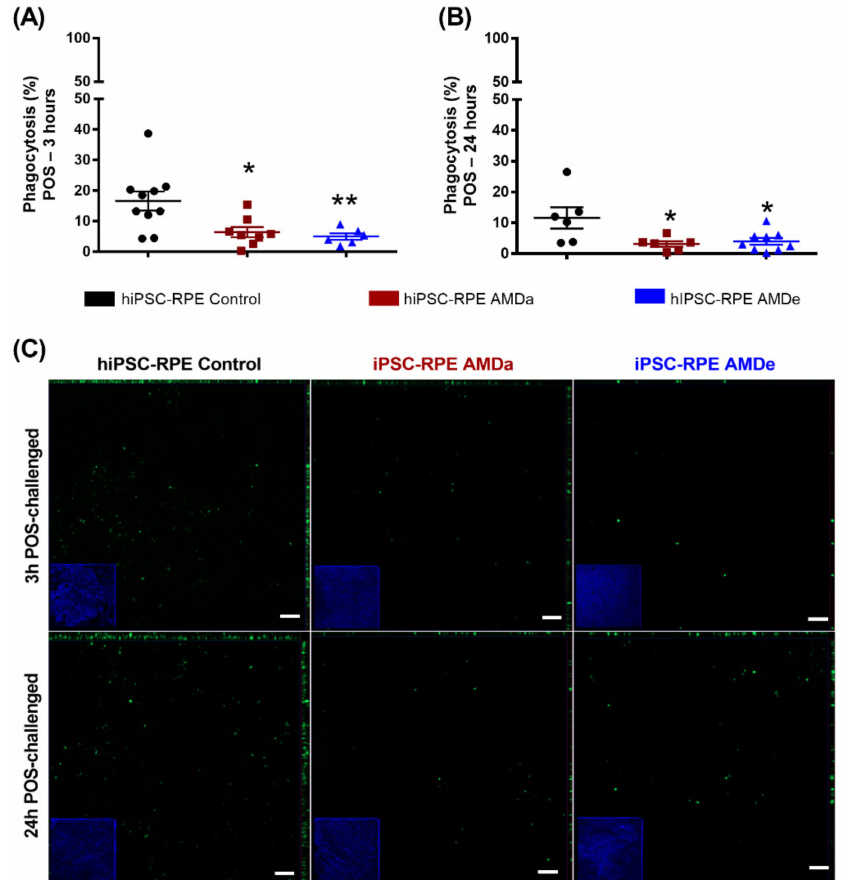
Figure 2. Specific phagocytosis function of hiPSC RPE Control and AMDa/e cell lines in basal condition. Quantification of 3 h POS exposure ( A ) and 24 h POS exposure ( B ) in hiPSC RPE Control (N = 5, n = 2), AMDa (N = 6, n = 2) and AMDe (N = 3, n = 2) cells in basal condition. Representative immunofluorescence of 3 and 24 h POS exposure in hiPSC-RPE Control and AMDa/e cells ( C ). Micro- graphs on the borders are related to an orthogonal view of hiPSC-RPE cells (N = 2), AMDa (N = 3) and AMDe (N = 3) Scale: 50 µ m. Statistical analysis: Kruskal–Wallis. * p < 0.05 ** p <